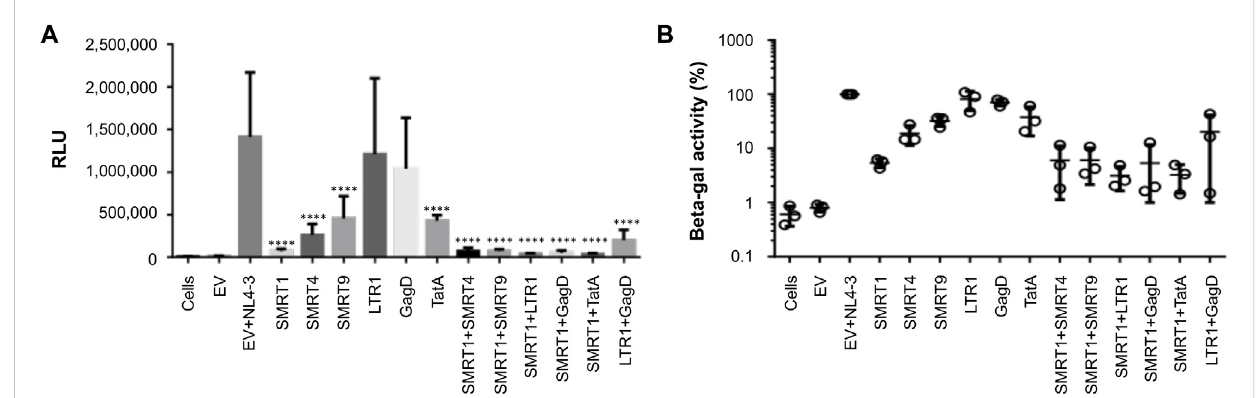
FIGURE 6 Combination gRNAs lead to a near100 percentreduction inLTR-mediated reportergene expression. TZM-bl cells were seeded in 96-well platesat 20,000 cells per well. Cells were then co-transfected with HIV-1 GFP and Cas9 plasmids. Forty eight hours post-transfection cells were processed for beta-galactosidase expression. (A) Quantitative representation of relative light units (RLU) with different gRNA treatment groups. (B) The EV with NL4-3 treatedgroupwasnormalizedto100percent,differentgRNAsinsingleandcombinationtreatmentswerecomparedtotheEV+NL4-3group.Error